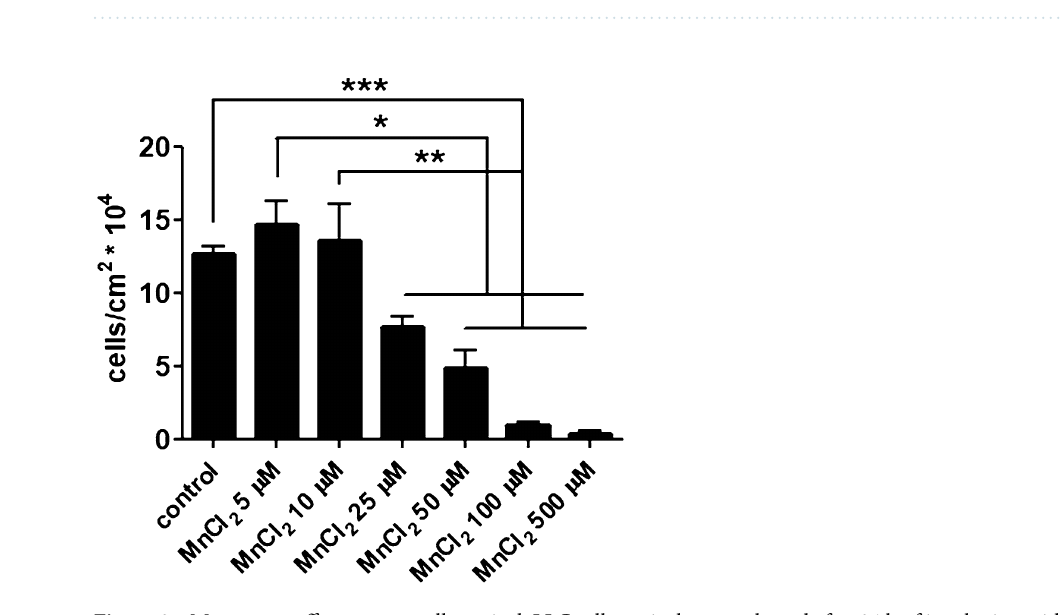
Table 1. Analysis of elemental composition within Mn-rich niches. * Kruskal–Wallis test.